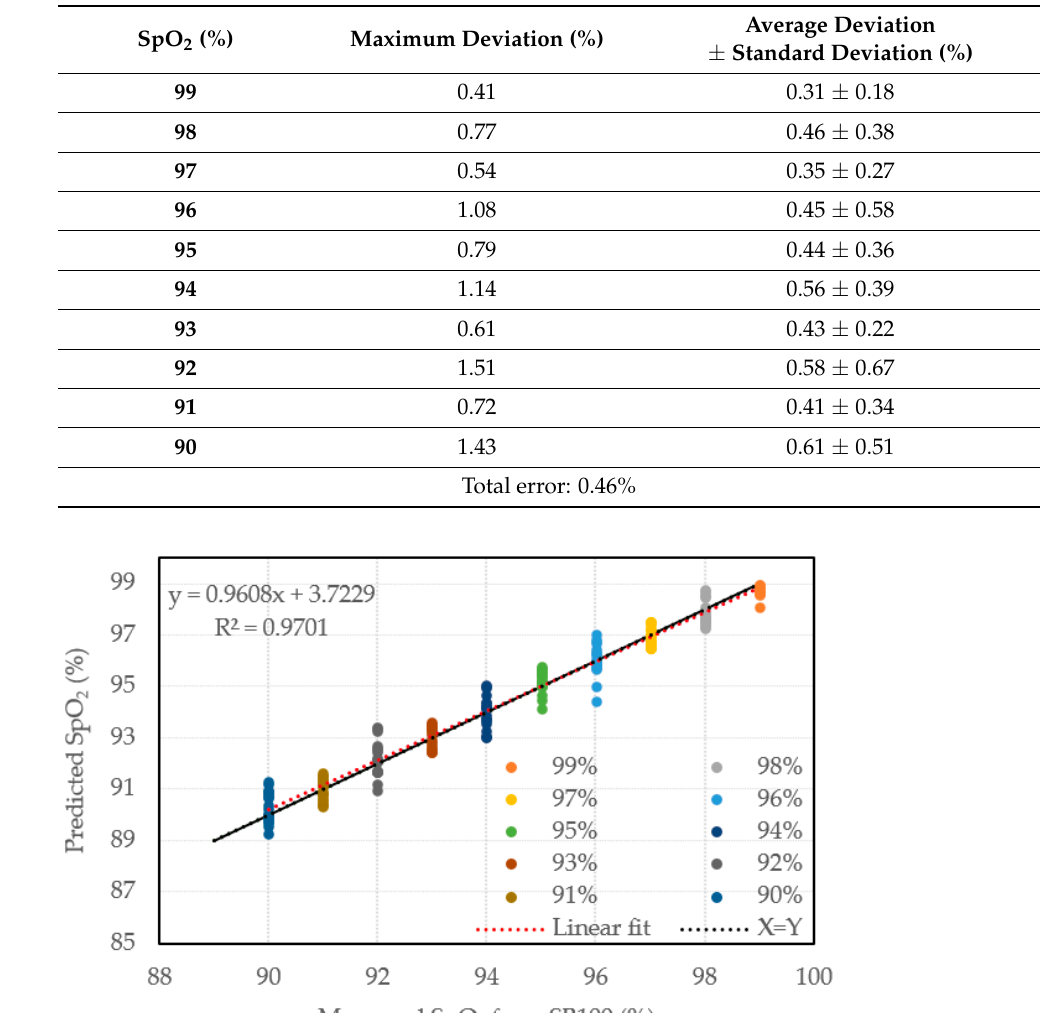
100 Table 7. Deviation of each SpO 2 . SpO 2 (%)